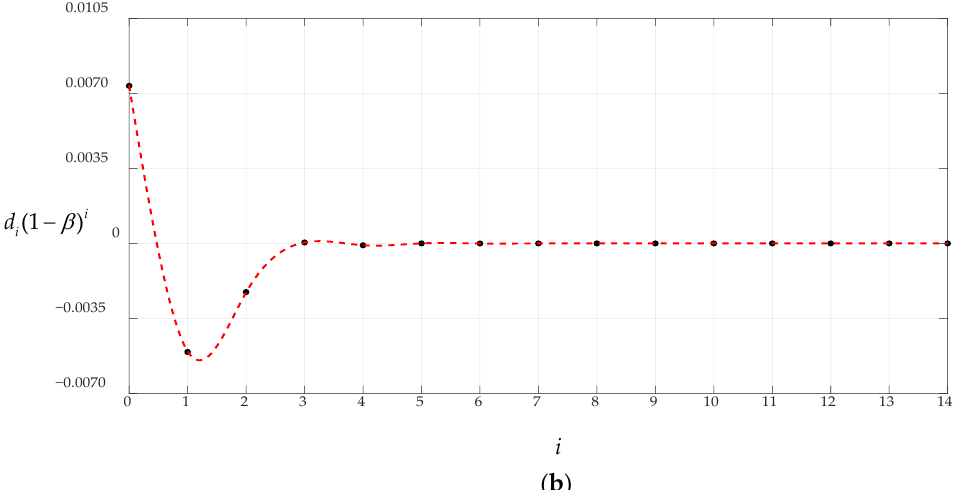
Figure 8. The variations of c i (1 − β ) i and d i (1 − β ) i with terms i , where q = 1.725 × 10 −6 MPa: ( a ) the variation of c i (1 − β ) i with i , and ( b ) the variation of d i (1 − β ) i with i .